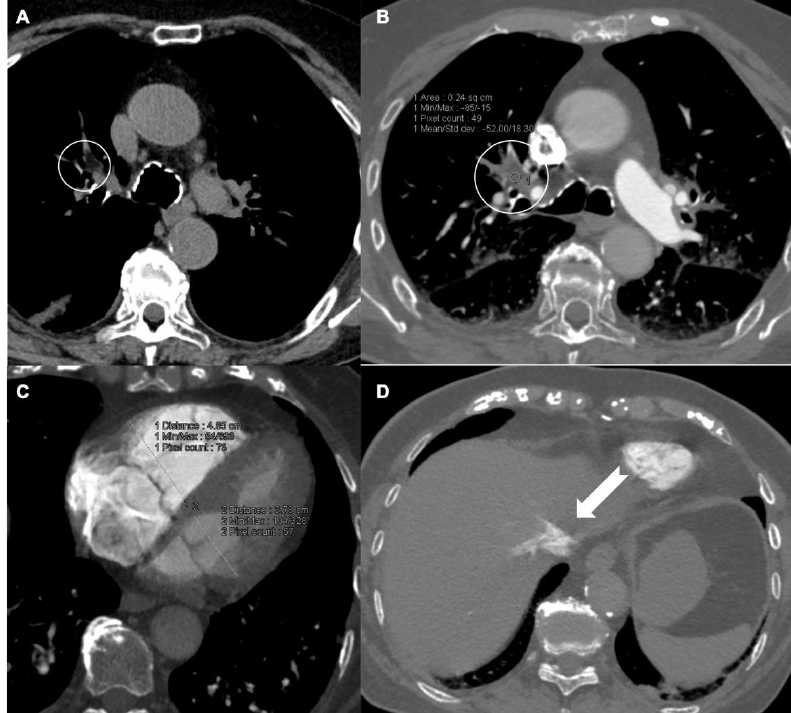
Figure 1. Patient with fat-filling defects in the right upper lobar pulmonary artery in non-contrast ( A ) and contrast ( B ) axial scans. ( C ) CTPA illustration of RV/LV diameter ratio measurement; the measurement in this patient was 1.26. (( D ), arrow) Reflux of contrast medium extended to hepatic veins (grade III). 3.2. Diameter of Pulmonary Artery